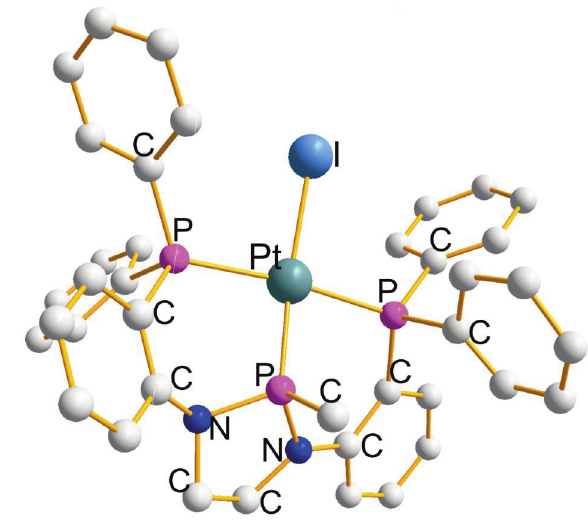
P(C H )S(=O)(C 2 6 4